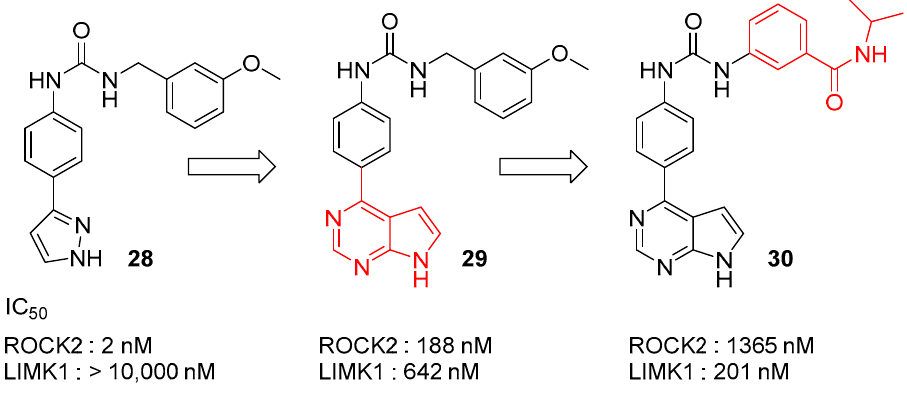
Figure 7. Progress toward LIMK inhibition.